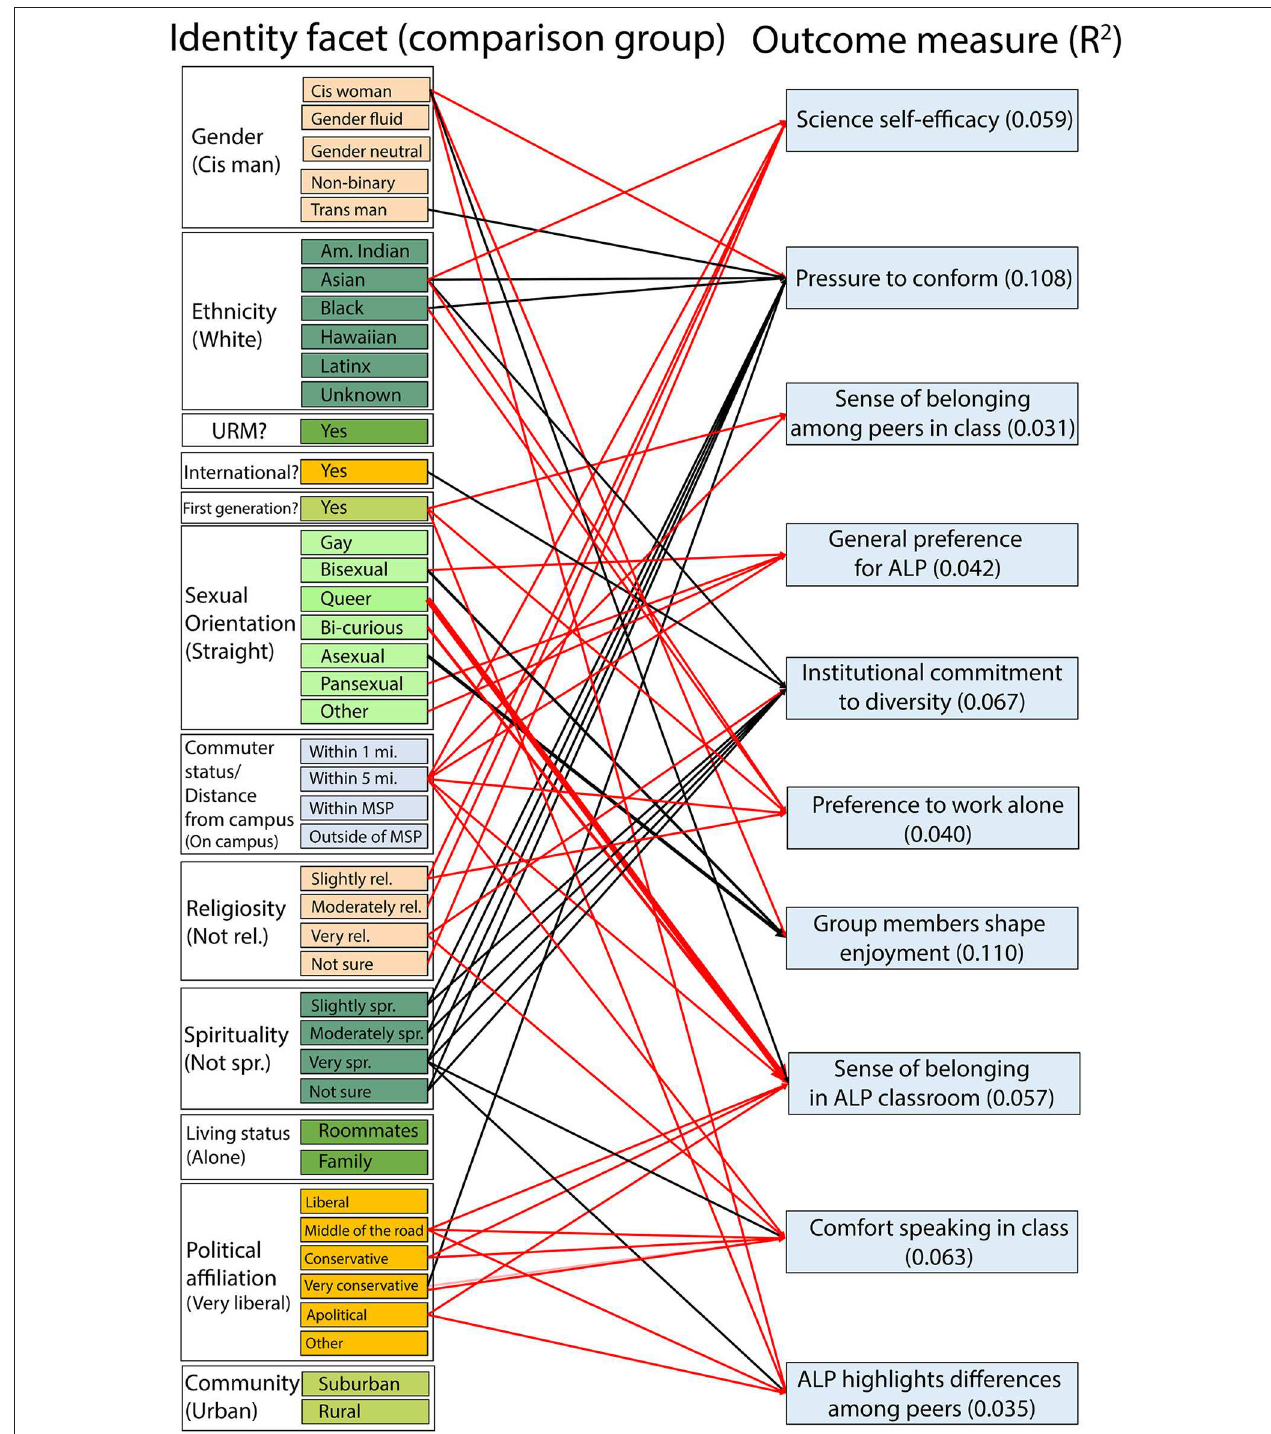
FIGURE 1 | Multiple identities influence student perceptions of active learning environments. Our best path model (AICc = 781.344, Fisher’s C 60 = 214.12, p = 0.998, Figure 1 ) included 10 of 14 outcome measures, four of which were removed because of low explanatory power with our identity facets. This model illustrates significant negative (in red) and positive (in black) associations between student identities (e.g., gender, spirituality) and perceptions of active learning, such as whether group work shapes their enjoyment in the course, or whether they prefer active learning classes. Additionally, we created a series of subset versions of this figure to highlight how gender identity ( Figure S1 ), first generation college students ( Figure S2 ), religiosity and political affiliations ( Figure S3 ), and sexual orientation ( Figure S4 ) shape perceptions of active learning environments. Lines are weighted to denote the strength of the association (i.e., by path coefficients).